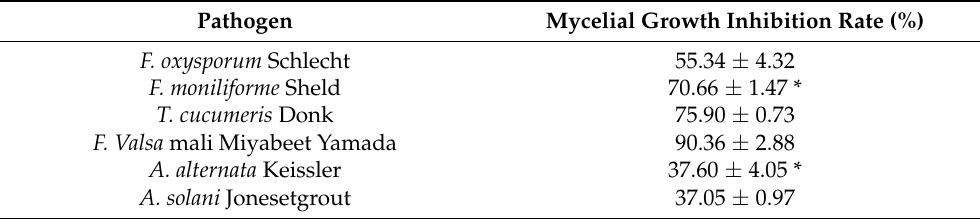
Figure 4. Inhibitory effect of osthole on several fungal pathogens. ( A ) F. oxysporum Schlecht; ( B ) F. moniliforme Sheld); ( C ) T. cucumeris Donk; ( D ) V. mali Miyabeet Yamada); ( E ) A. solani Jonesetgrout; ( F ) A. alternata Keissler. PDA containing osthole (5 mg/mL) was used. CK, PDA dishes were added with the same volume of Tween-20 and distilled water (1:1000 v/v ). Table 2. Mycelial diameter of six pathogens in response to osthole treatment in vitro.